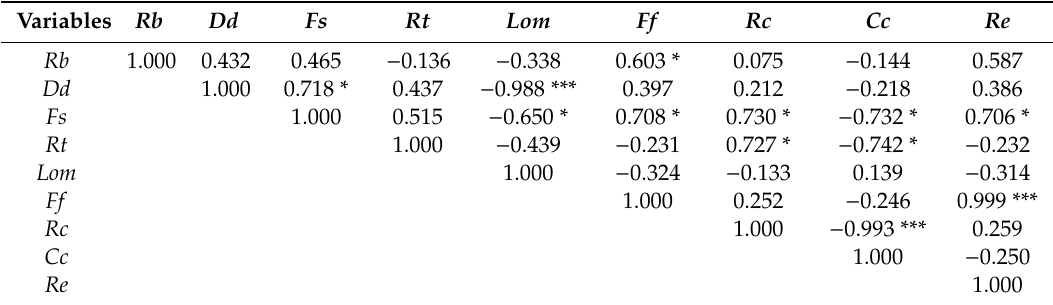
Table 6. Correlation matrix between linear, areal, and shape morphometric variables of the four HAL-MWs in Leimebamba and two HAL-MWs in Molinopampa (Amazonas, Peru).